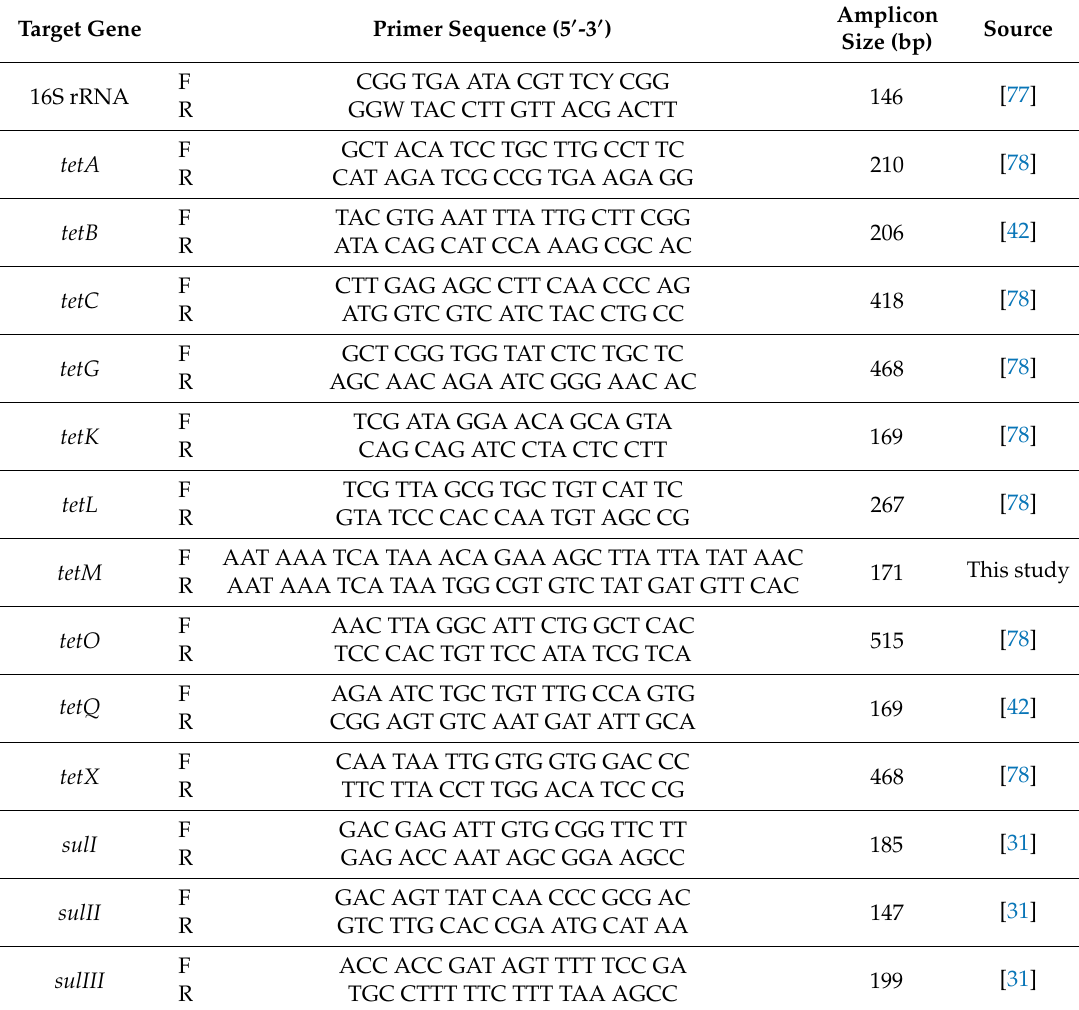
Table 5. PCR and qPCR amplification